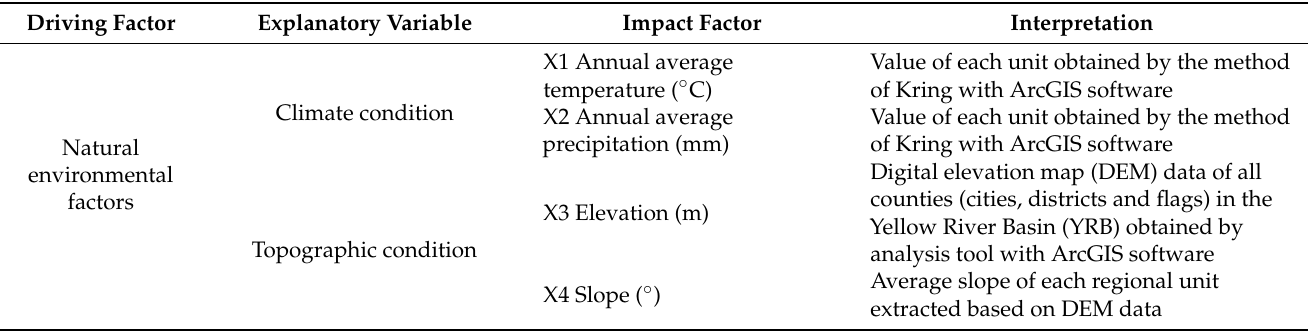
Table 2. Explanatory variables relevant to spatiotemporal variation of carbon